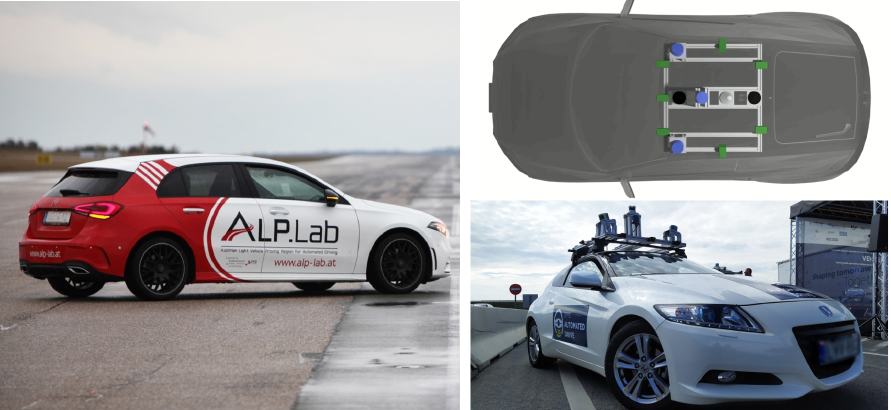
Figure 12. ALP.Lab test vehicle used during the measurement campaign ( left ) and sensor setup of the Budapest University of Technology and Economics (BME) measurement vehicle ( right